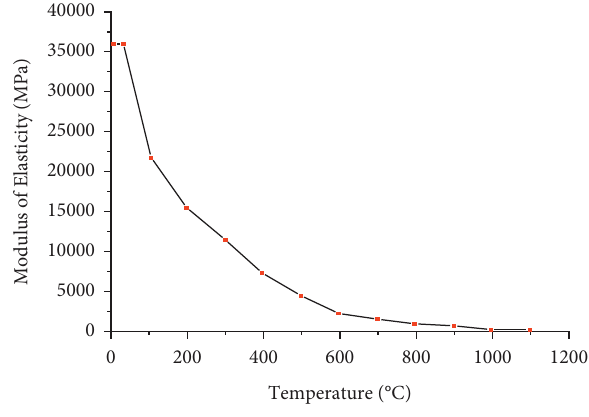
Figure 17: Termal elongation of steel at elevated temperature [19].